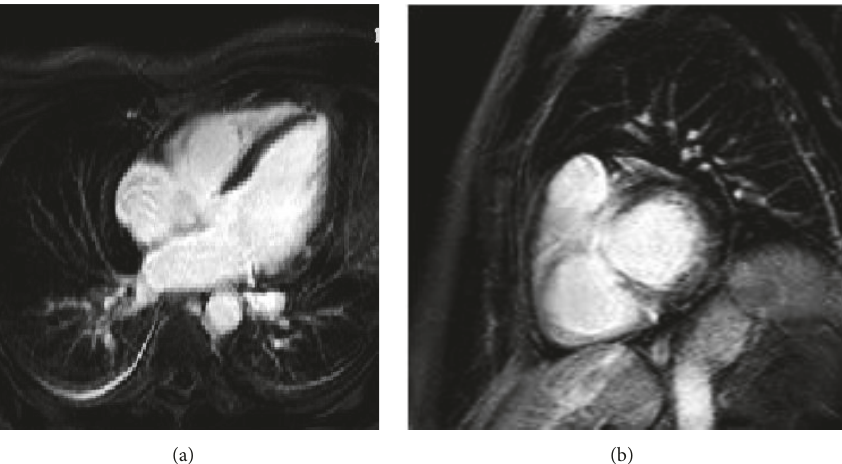
Figure 6: LGE images of a patient with pulmonary sarcoidosis with cardiac involvement. Four-chamber view (a) showing mid-wall focal enhancement in the lateral wall of the left ventricle and in the apex. Note also the enhancement of the mediastinal lymph nodes. Short axis view (b) demonstrating enhancement of the LVOT and possibly of the RVOT. Images courtesy of Professor Dr. Jan Bogaert, University Hospital